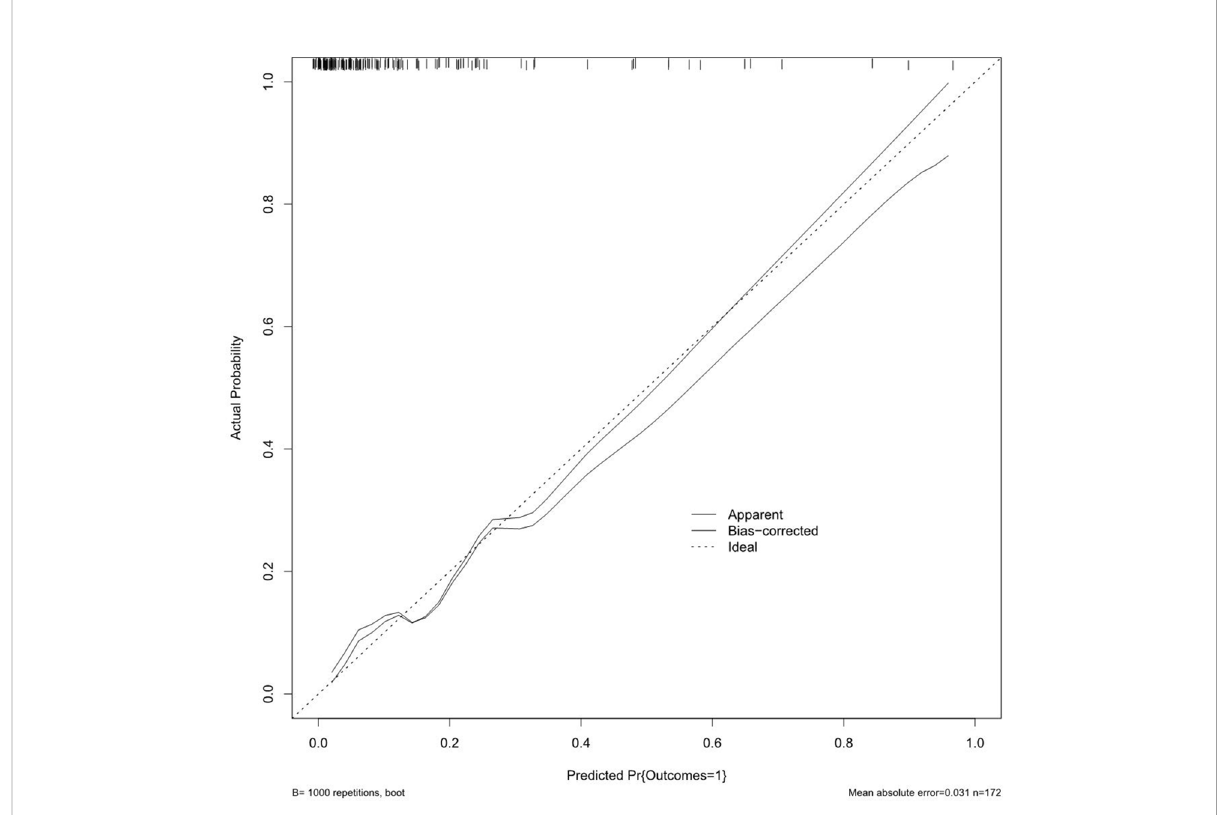
FIGURE 4 The calibration curves for the nomogram. The x -axis represents the nomogram-predicted probability, and y -axis represents the actual probability of incomplete biochemical